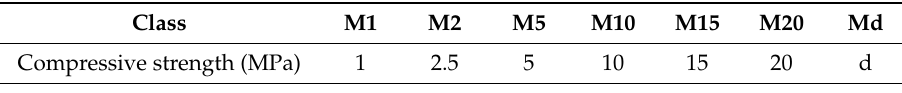
Table 9. Masonry mortar classes according to the compressive